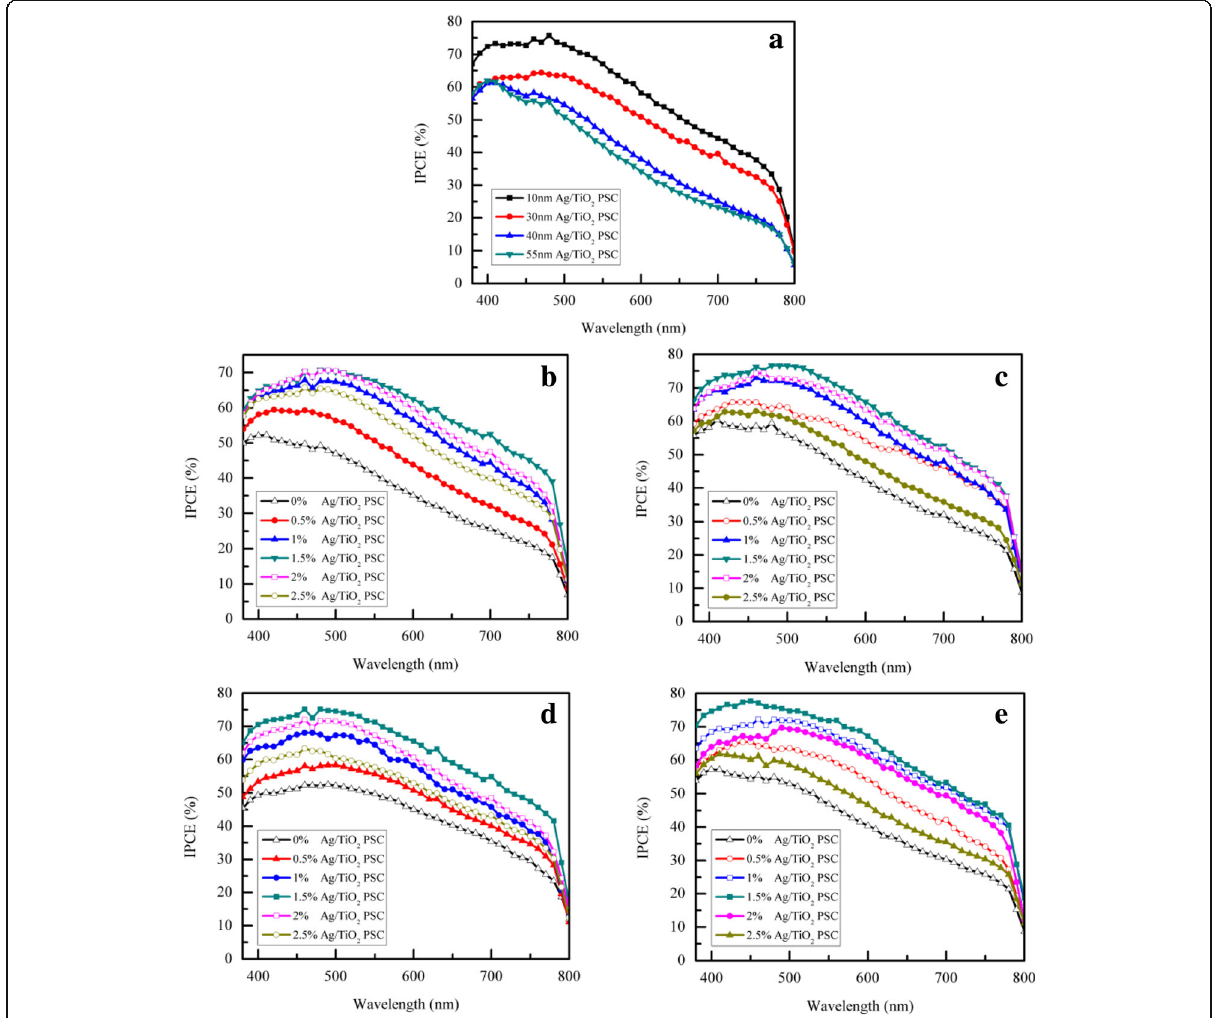
Fig. 8 IPCE spectra (380 to 800 nm) of PSC devices with a different sizes of Ag NPs, b different content of 10-nm Ag NPs, c different content of 30-nm Ag NPs, d different content of 40-nm Ag NPs, and e different content of 55-nm Ag